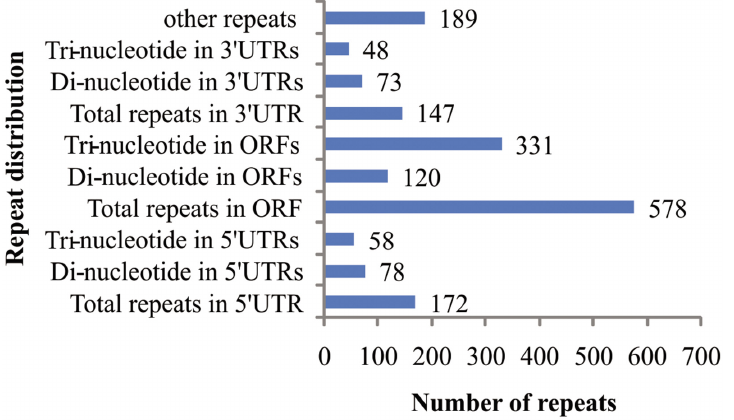
Fig 5. Distribution of genic-SSR motifs in the coding sequence and untranslated region (UTRs) of black gram transcriptome sequences.